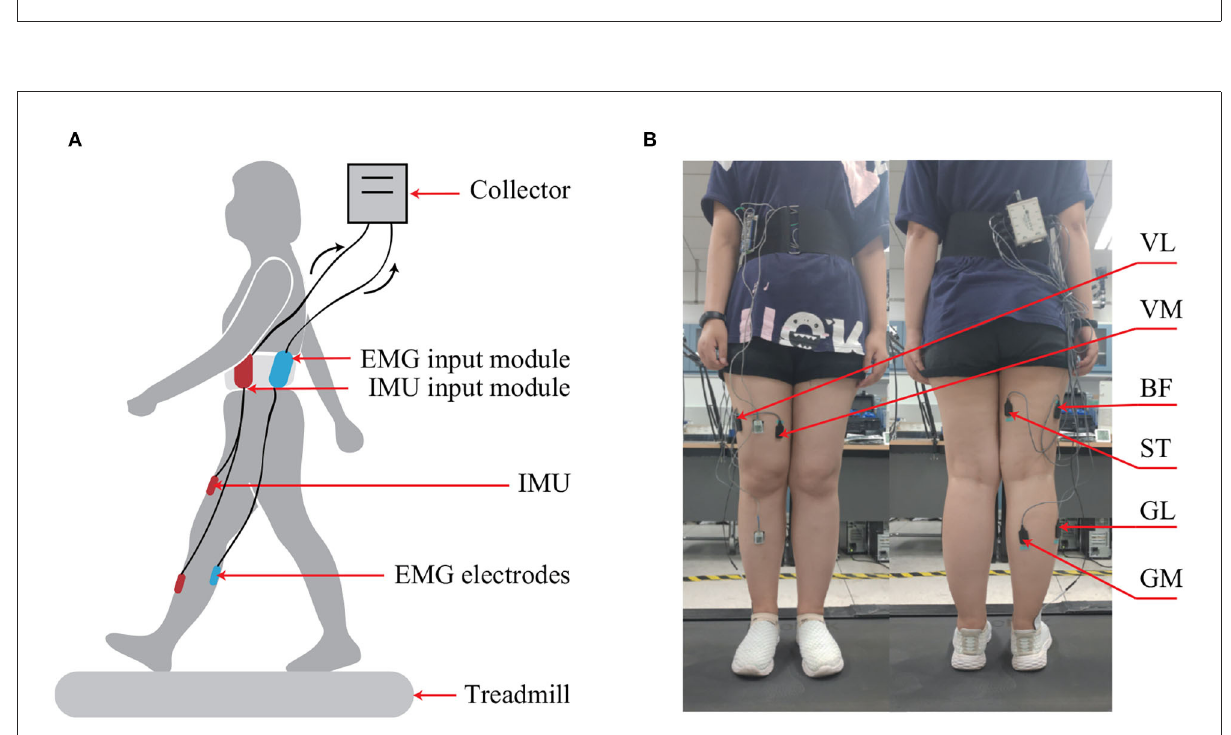
FIGURE2 The experimental setup. (A) Schematic diagram of the experimental setup. (B) The locations of sEMG electrodes.